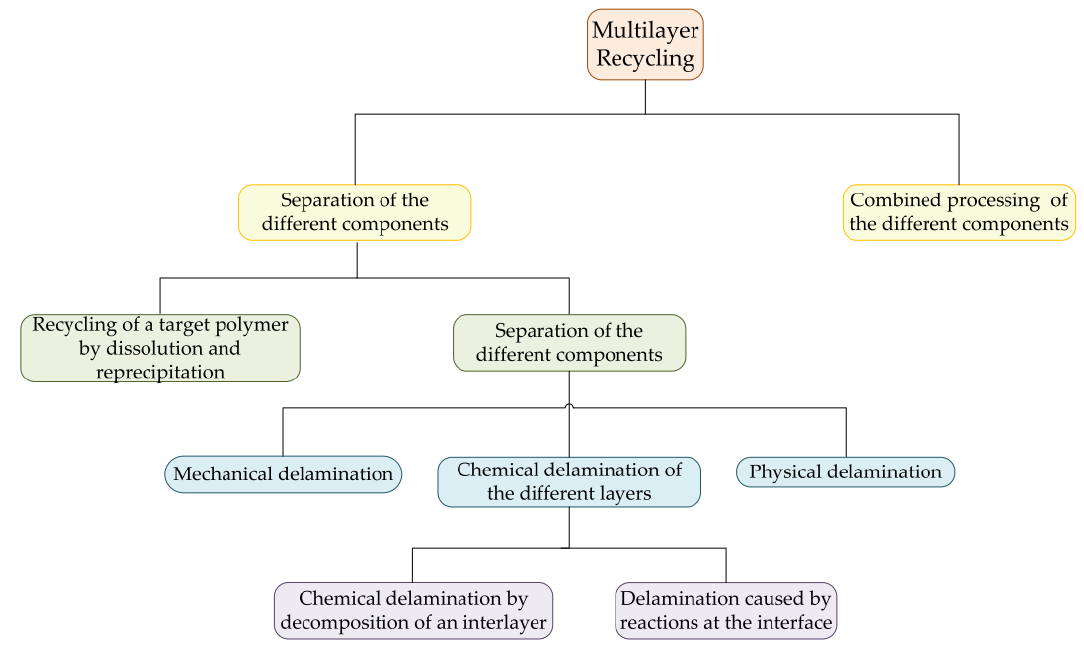
Figure 7. Summary of the introduced recycling methods of multilayers films waste. Adapted from [2]. (Copyright 2022, Elsevier).